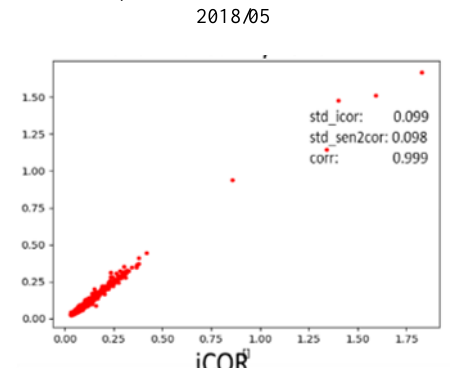
Figure 7. Scatterplot for Sen2Cor and iCOR in urban area. 2018/11.